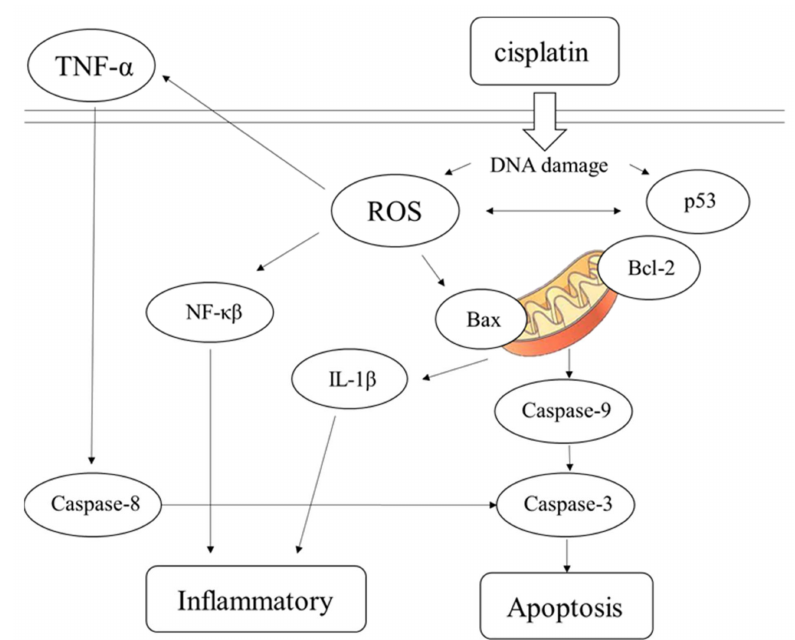
Figure 8. The speculated pathway of inflammation and apoptosis caused by cisplatin in NRK- 52E